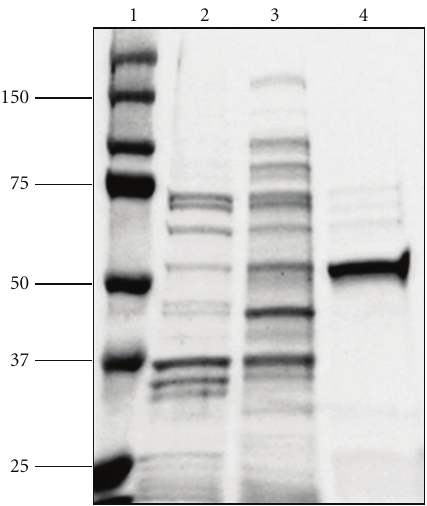
Figure 3: Recombinant expression and purification of At5g36160 from the E. coli strain BL21 Codon Plus RIPL. The enzyme was purified as described in Section 2. Along with the molecular mass markers (kDa) (lane 1), the gel shows the profile of 10 μ g soluble proteins extracted from uninduced (lane 2) and induced cells (lane 3). Lane 4 shows the profile of 1.0 μ g of the purified recombinant enzyme. The proteins were resolved on an SDS-PAGE gel containing 10% (w/v) acrylamide, and the gel was stained using Coomassie